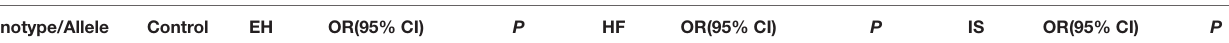
TABLE 2 | Association of WNT3A rs752107 variant with EH, HF, and IS. Genotype/Allele